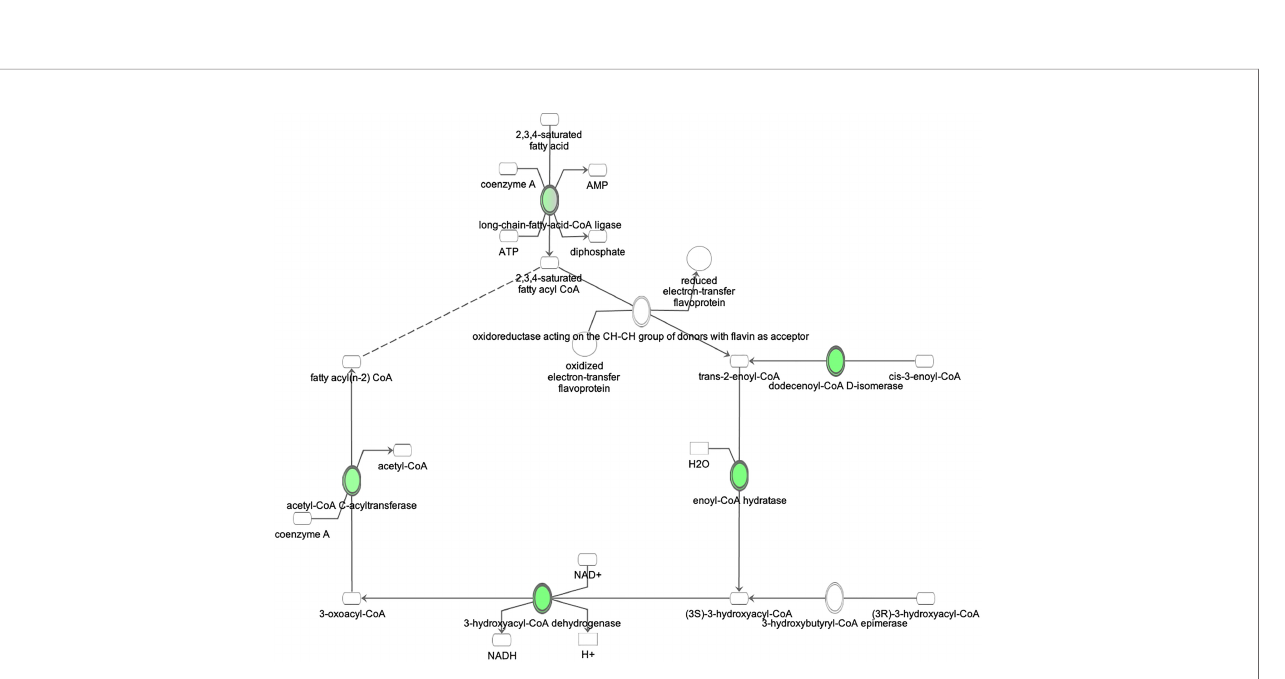
FIGURE 6 | Ingenuity Pathway Analysis of DEPs between FGR vs. Control group. Inhibition of fatty acid beta oxidation. (z = − 2.0, p = 2.7e-3)